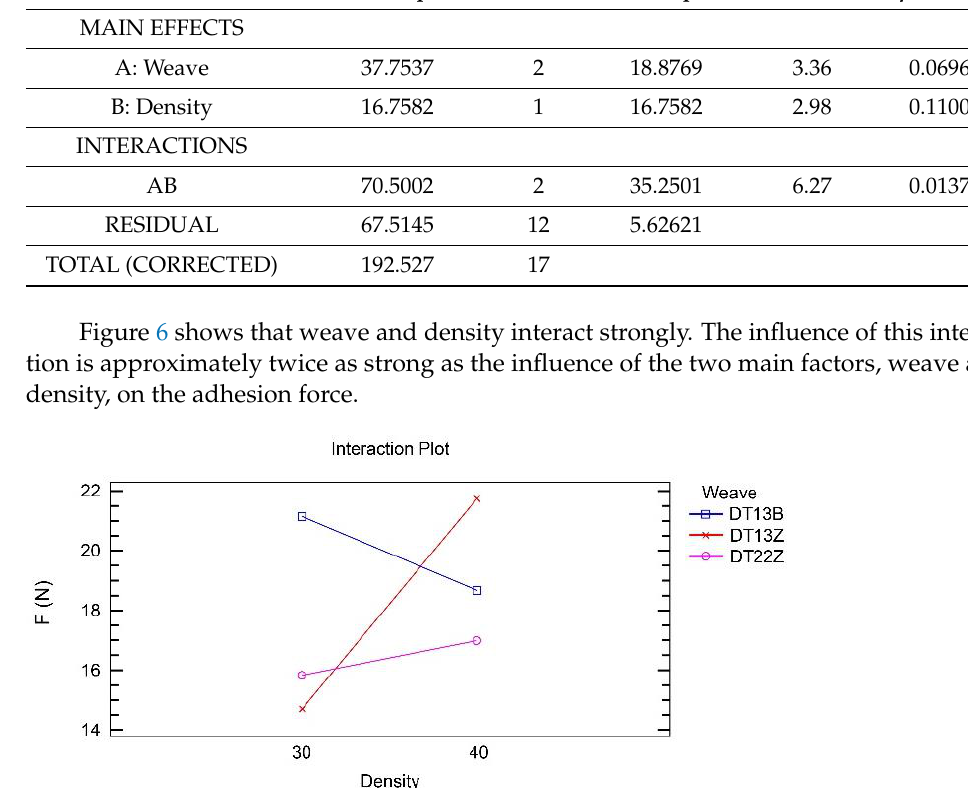
Table 9. Impact of weave and density on the adhesion force for double fabrics for z2.